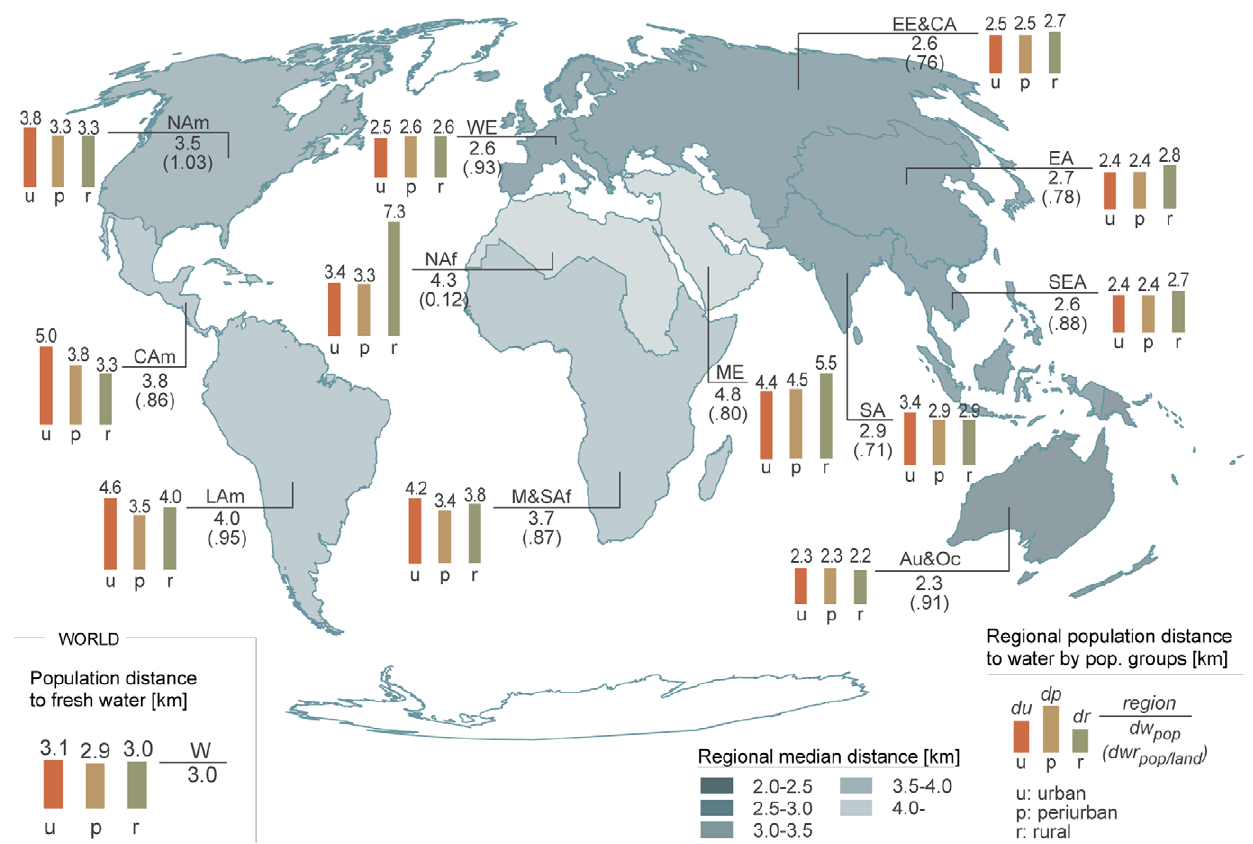
Figure 4. Regional results for population distance to fresh water ( dw pop ) with subdivision of population groups. Columns show the results per population class (urban, peri-urban, rural) while the total average distance to water is presented below the abbreviation of the region. The abbreviations for the regions are as follows: Au&Oc-Australia and Oceania; CAm-Central America; EA-Eastern Asia; EE&CA-Eastern Europe and Central Asia; SA-South Asia; LAm-Latin America; ME-Middle East; M&SAf-Middle and Southern Africa; NAf-North Africa; NAm-North America; SEA-Southeast Asia; and WE-Western Europe.